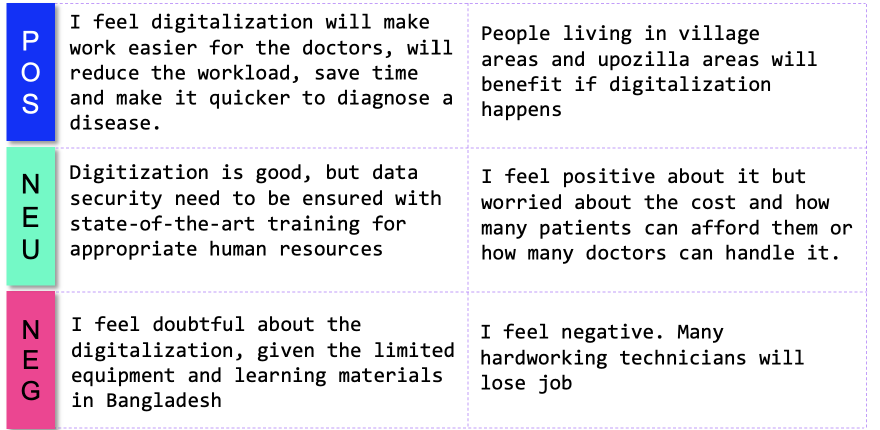
Figure 10. Example of comments and their class predicted by